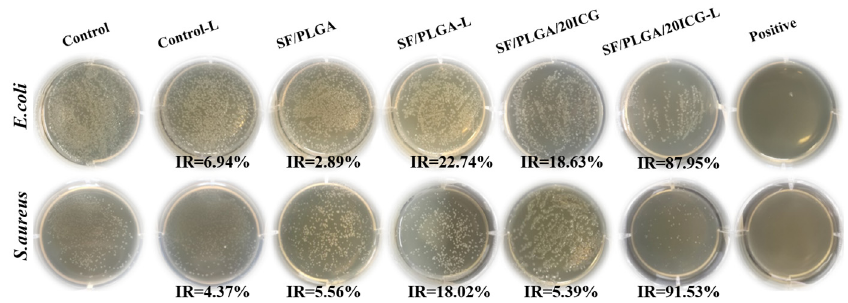
Figure 5. Antimicrobial effect of each group of membranes.